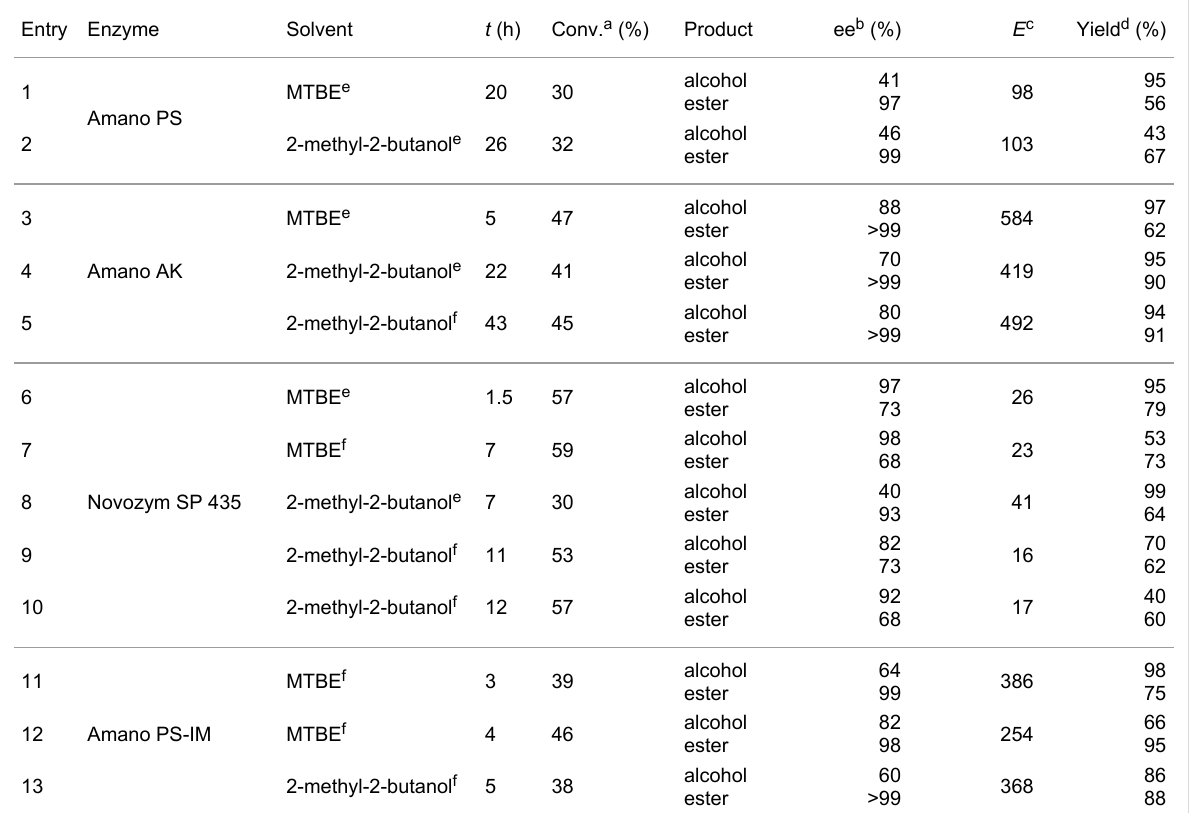
Table 1: Lipase-catalyzed resolution of racemic 1-(1 H -imidazol-1-yl)propan-2-ol (±)- 3a .